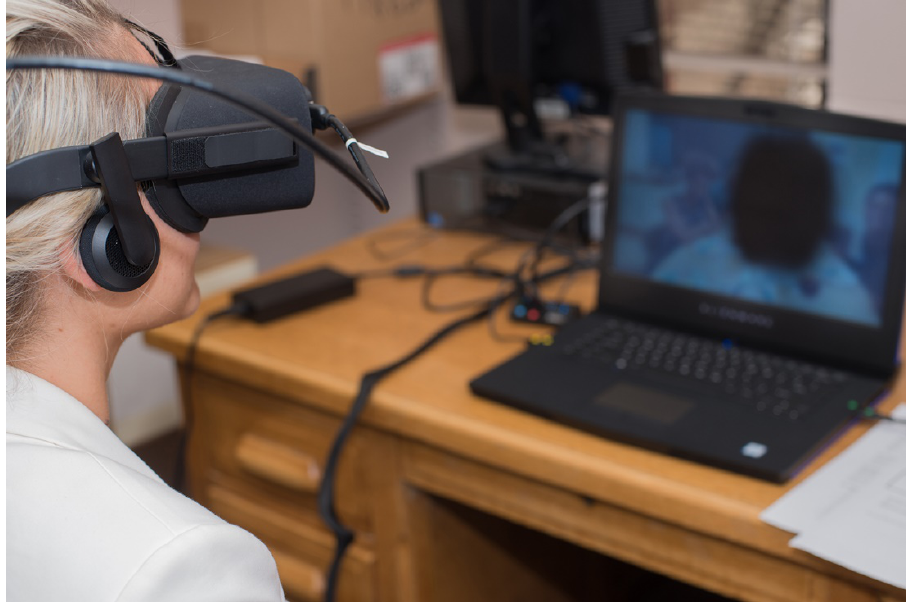
Figure 1 University of New England virtual reality